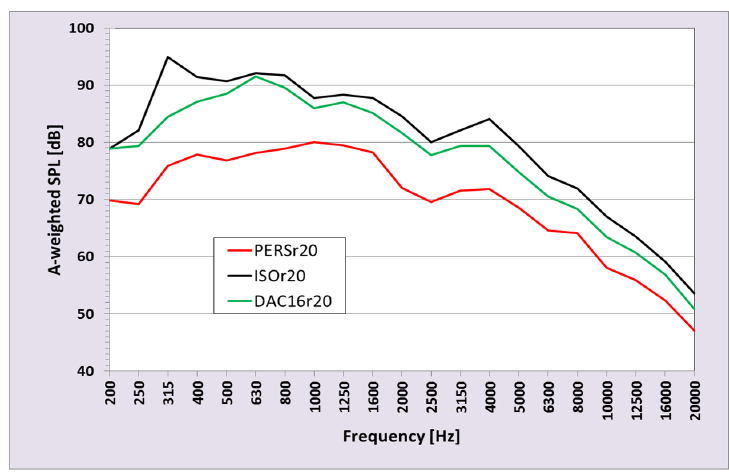
Figure 4. Comparison of spectra for truck tire T1085 at speed 80 km/h (PERS is the PERS ‐ HET ‐ type).